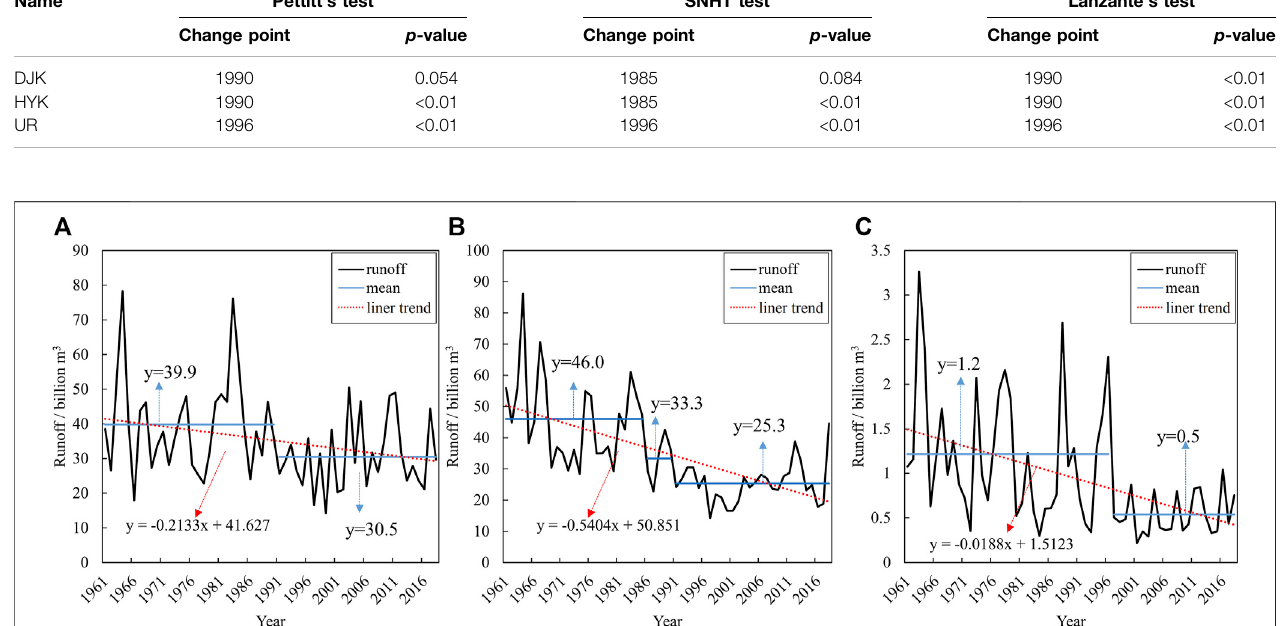
FIGURE 3 | Linear regression curve and mean values before and after change points from 1961 to 2018: (A) DJK, (B) HYK, and (C) UR.